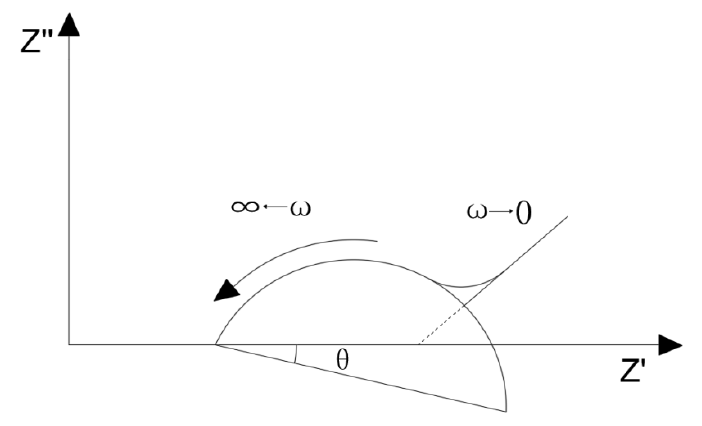
Figure 7. Nyquist diagram corresponding to the quasi-Randles model [25].